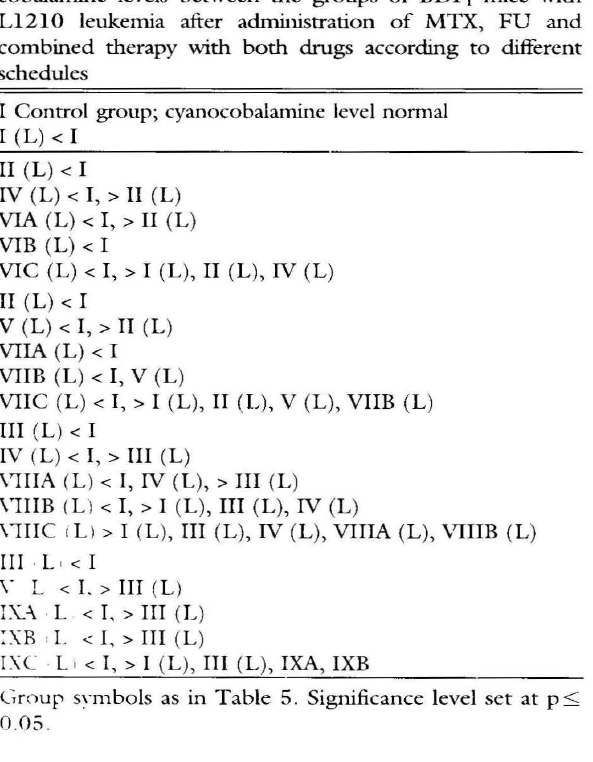
Table 7. N S-methyltetrahydrofolate levels in the serum of EDF, mice after administration of MTX, FU and com- bined therapy according to different schedules